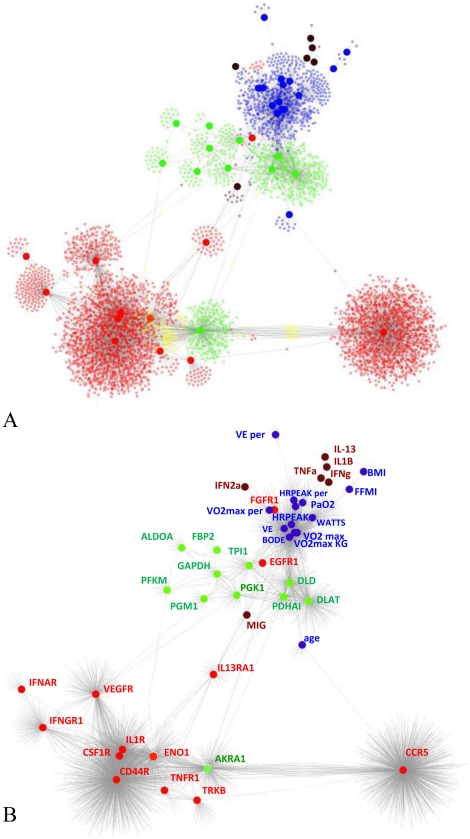
Network integrating multi-level measurements in the 8 weeks training study.The figure shows the network representing the relationship between physiological measurements, serum cytokine levels and mRNA expression profiles in the muscle, following ARACNE analysis of the 8 weeks training dataset. Panel A shows an outline of the network topology where individual network hubs have been annotated. Red nodes represent genes coding for receptors for growth factors and immune system mediators, blue nodes represent physiological measurements, brown nodes represent serum cytokines, and green nodes represent gene expression of enzymes in the glycolysis and gluconeogenesis pathways. Panel B shows all nodes in the network (representing 16350 genes or measurements). The colour of nodes follows the same code as panel A. In addition yellow nodes represent genes in common between cytokine and growth factor and glycolysis/gluconeogenesis network hubs.